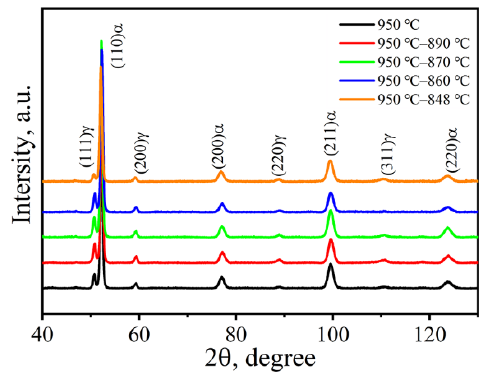
Figure 12. XRD patterns of the specimens after high-temperature two-step isothermal treatment. Table 2. The volume fraction of the retained austenite of the samples after high-temperature two- step isothermal treatment.